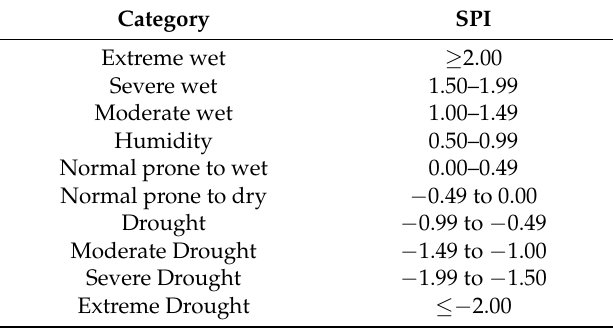
Table 1. Standardized precipitation index (SPI) categories, based on the criteria provided by McKee et al.